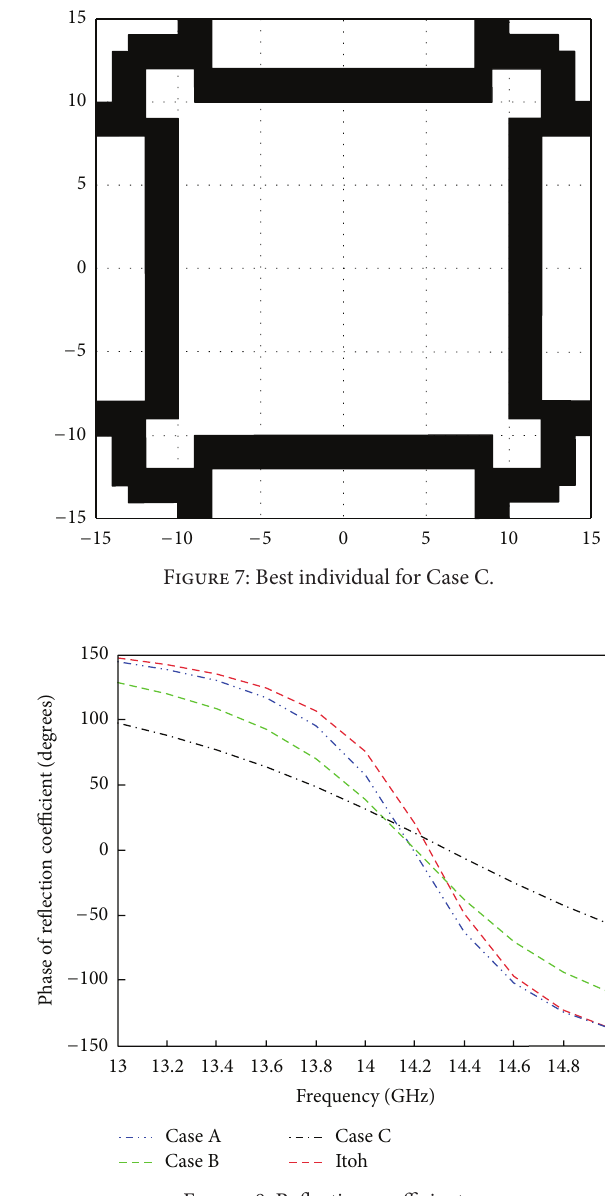
Figure 6: Best individual for Case B.